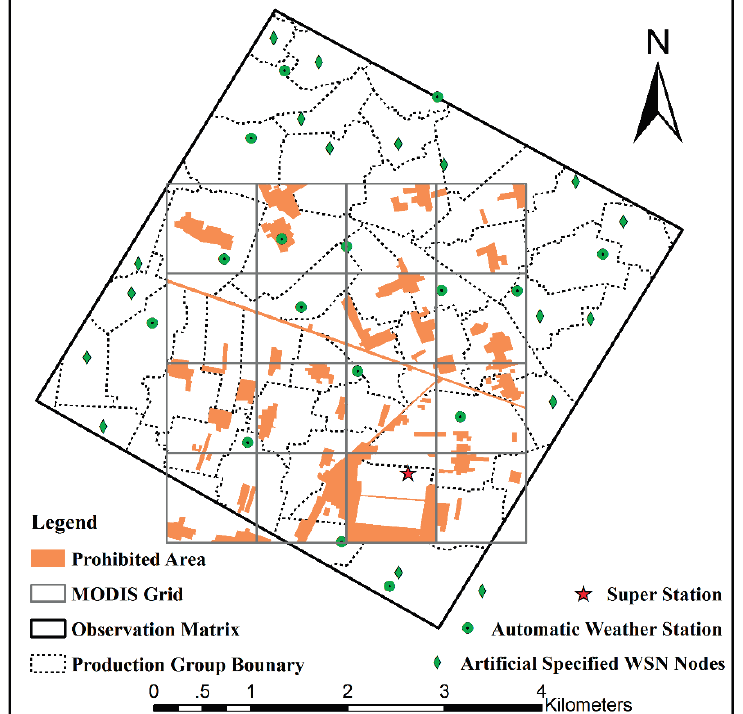
Figure 2. Initial eco-hydrological wireless sensor network (EHWSN) nodes in the optimization